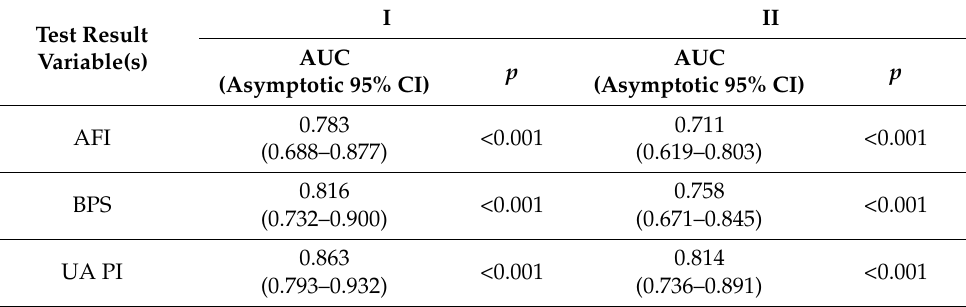
Table 4. Diagnostic parameter sensitivity and specificity—ROC by comparing: I—neonates with morbidity/mortality (bad outcome) with neonates with acidosis/asphyxia but without neonatal mor- bidity and neonates without neonatal morbidity/acidosis/asphyxia (good outcome) and II—neonates with morbidity/mortality with neonates and acidosis/asphyxia but without neonatal morbidity (bad outcome) with neonates without neonatal morbidity/acidosis/asphyxia (good